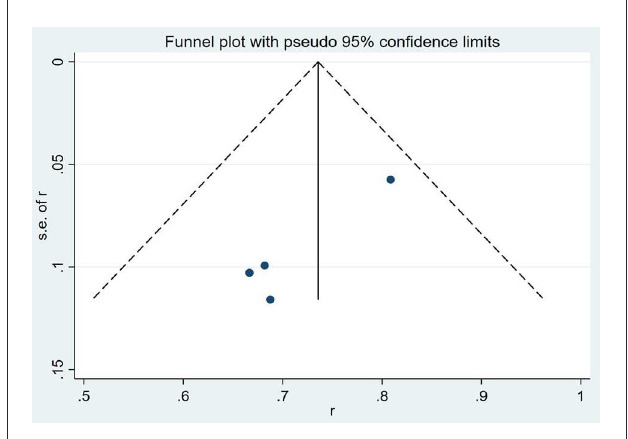
FIGURE4 Funnel plot analysis of complete occlusion rate at follow up.